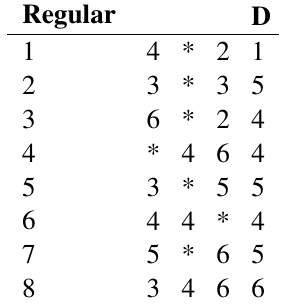
Table 2 Detection statistics rules table for data filtration